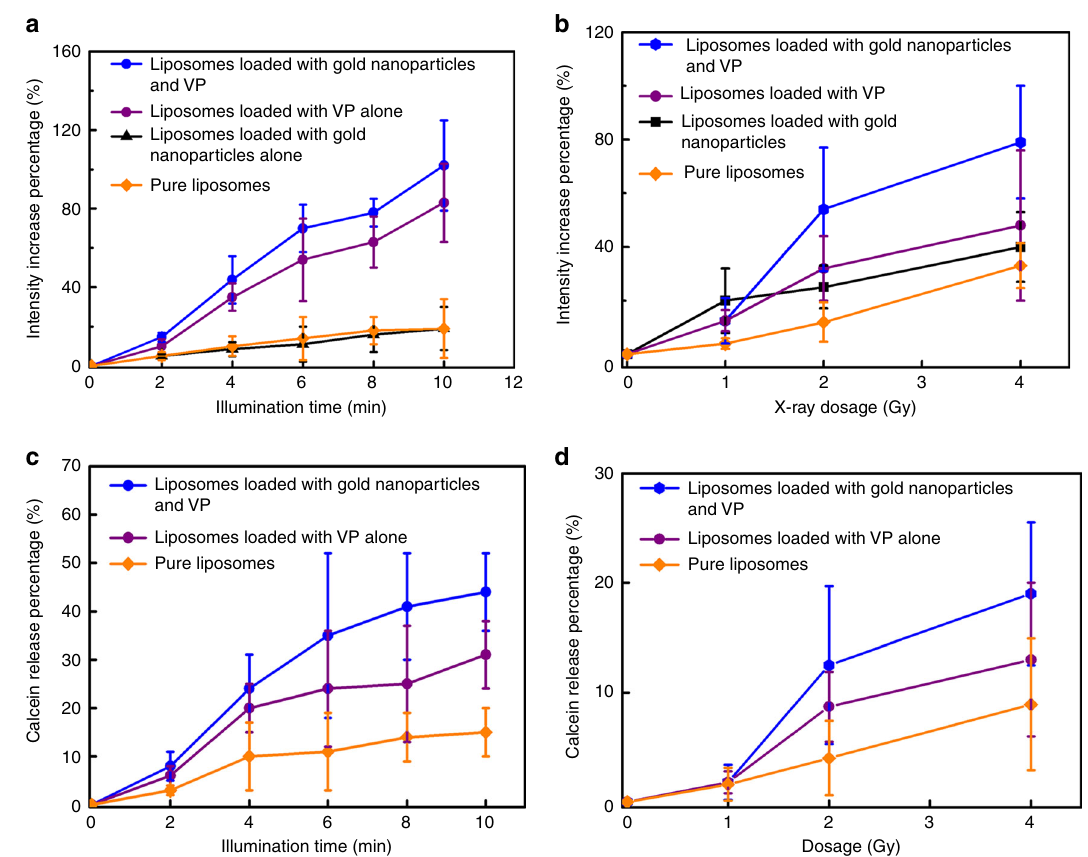
Fig. 2 Singlet oxygen generation and calcein release from liposomes under light and X-ray triggering. a , b Percentage increase of SOSG fl uorescence intensities from different liposome samples under ( a ) 360 nm irradiation at different time points and ( b ) X-ray radiation with different doses. c , d Calcein release pro fi les from liposomes under ( c ) 360 nm irradiation and ( d ) X-ray radiation. Error bars show standard deviation from four